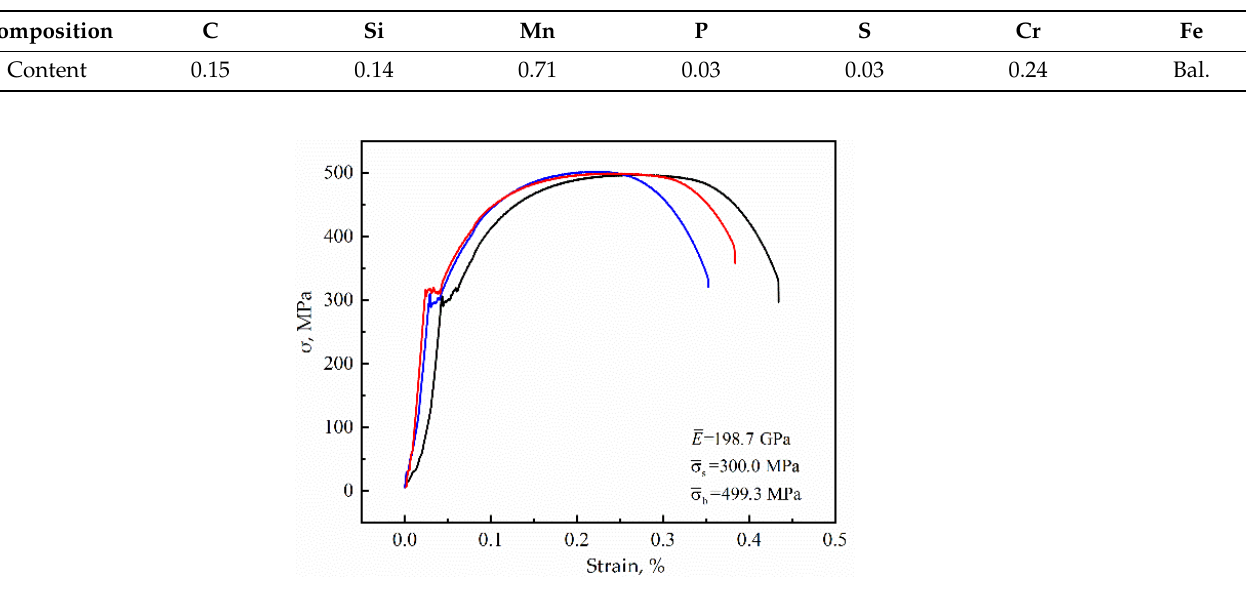
Figure 1. Engineering stress-strain curve. Table 1. Chemical composition (in weight %).